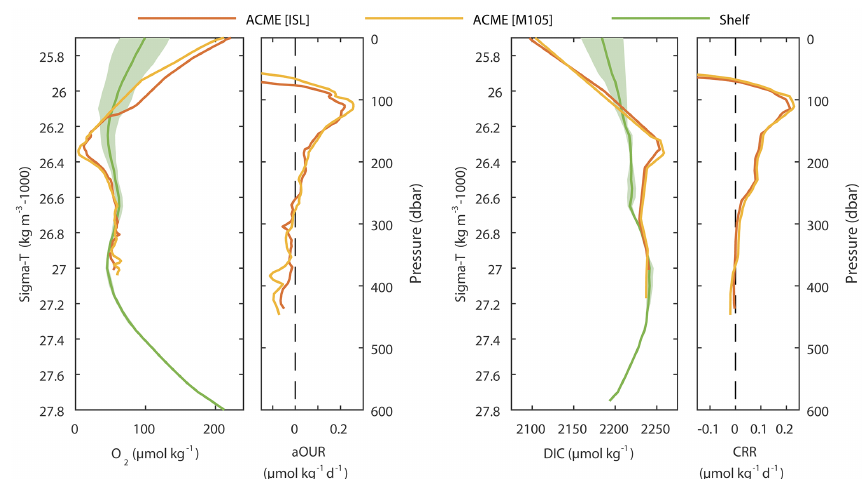
Figure 7. Estimated biogeochemical rates within the ACME as derived along isopycnals between the shelf (green) and the ACME at the time of the two surveys (red, yellow). This approach is illustrated for oxygen and DIC profile data (large panels). Corresponding aOUR and CRR are peaking in the core of the ACME (small panels). Note that the matching between shelf and ACME data was made in density space, whereas the resulting rates are plotted in depth